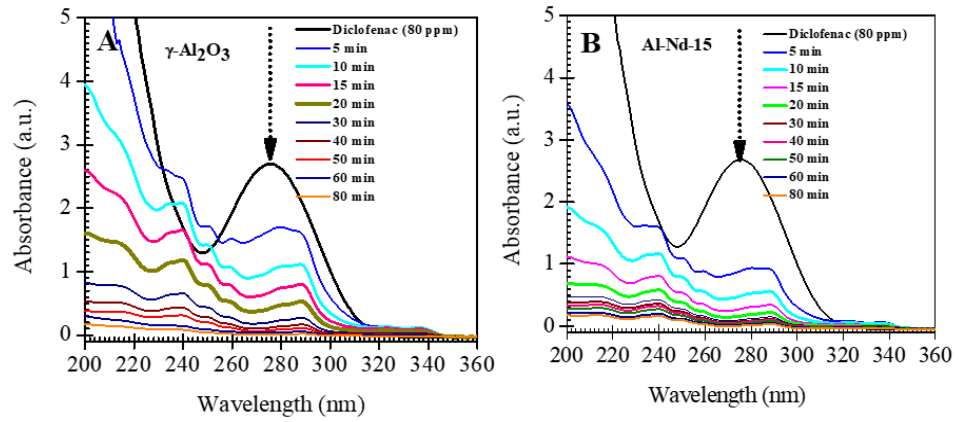
Figure 9. UV-Vis spectra of diclofenac after irradiation with UV light irradiation using: ( A ) γ -Al 2 O 3 ; ( B ) Al-Nd-15 binary oxide.